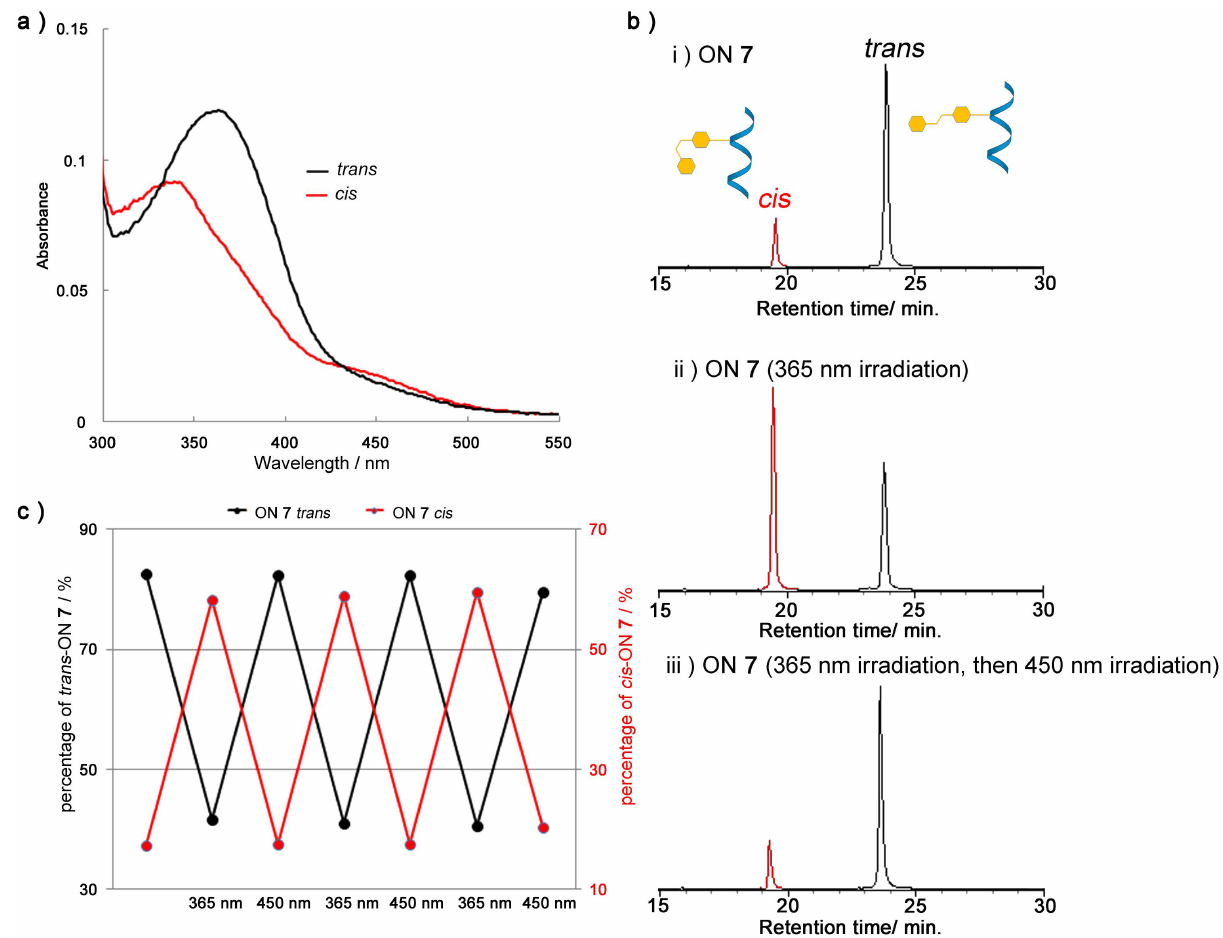
Figure 2. Photoisomerization properties of dU Az in oligodeoxynucleotide. ( a ) Absorbance spectra of trans- (black line) and cis- (red line) ON 7 . ( b ) HPLC analysis of the photoisomerization of ON 7 ; (i) Before irradiation; (ii) after 365 nm irradiation for 10 s; (iii) subsequent irradiation at 450 nm, 10 s. ( c ) Repetitive photoisomerization of ON 7 induced by alternative light irradiation at 365 nm and 450 nm. The percentages of trans- (black line) and cis- (red line) ON 7 obtained from the HPLC peak areas are shown. Conditions: ON 7 (4.0 µM), NaCl (100mM) in sodium phosphate buffer (10 mM, pH 7.0) was irradiated at room